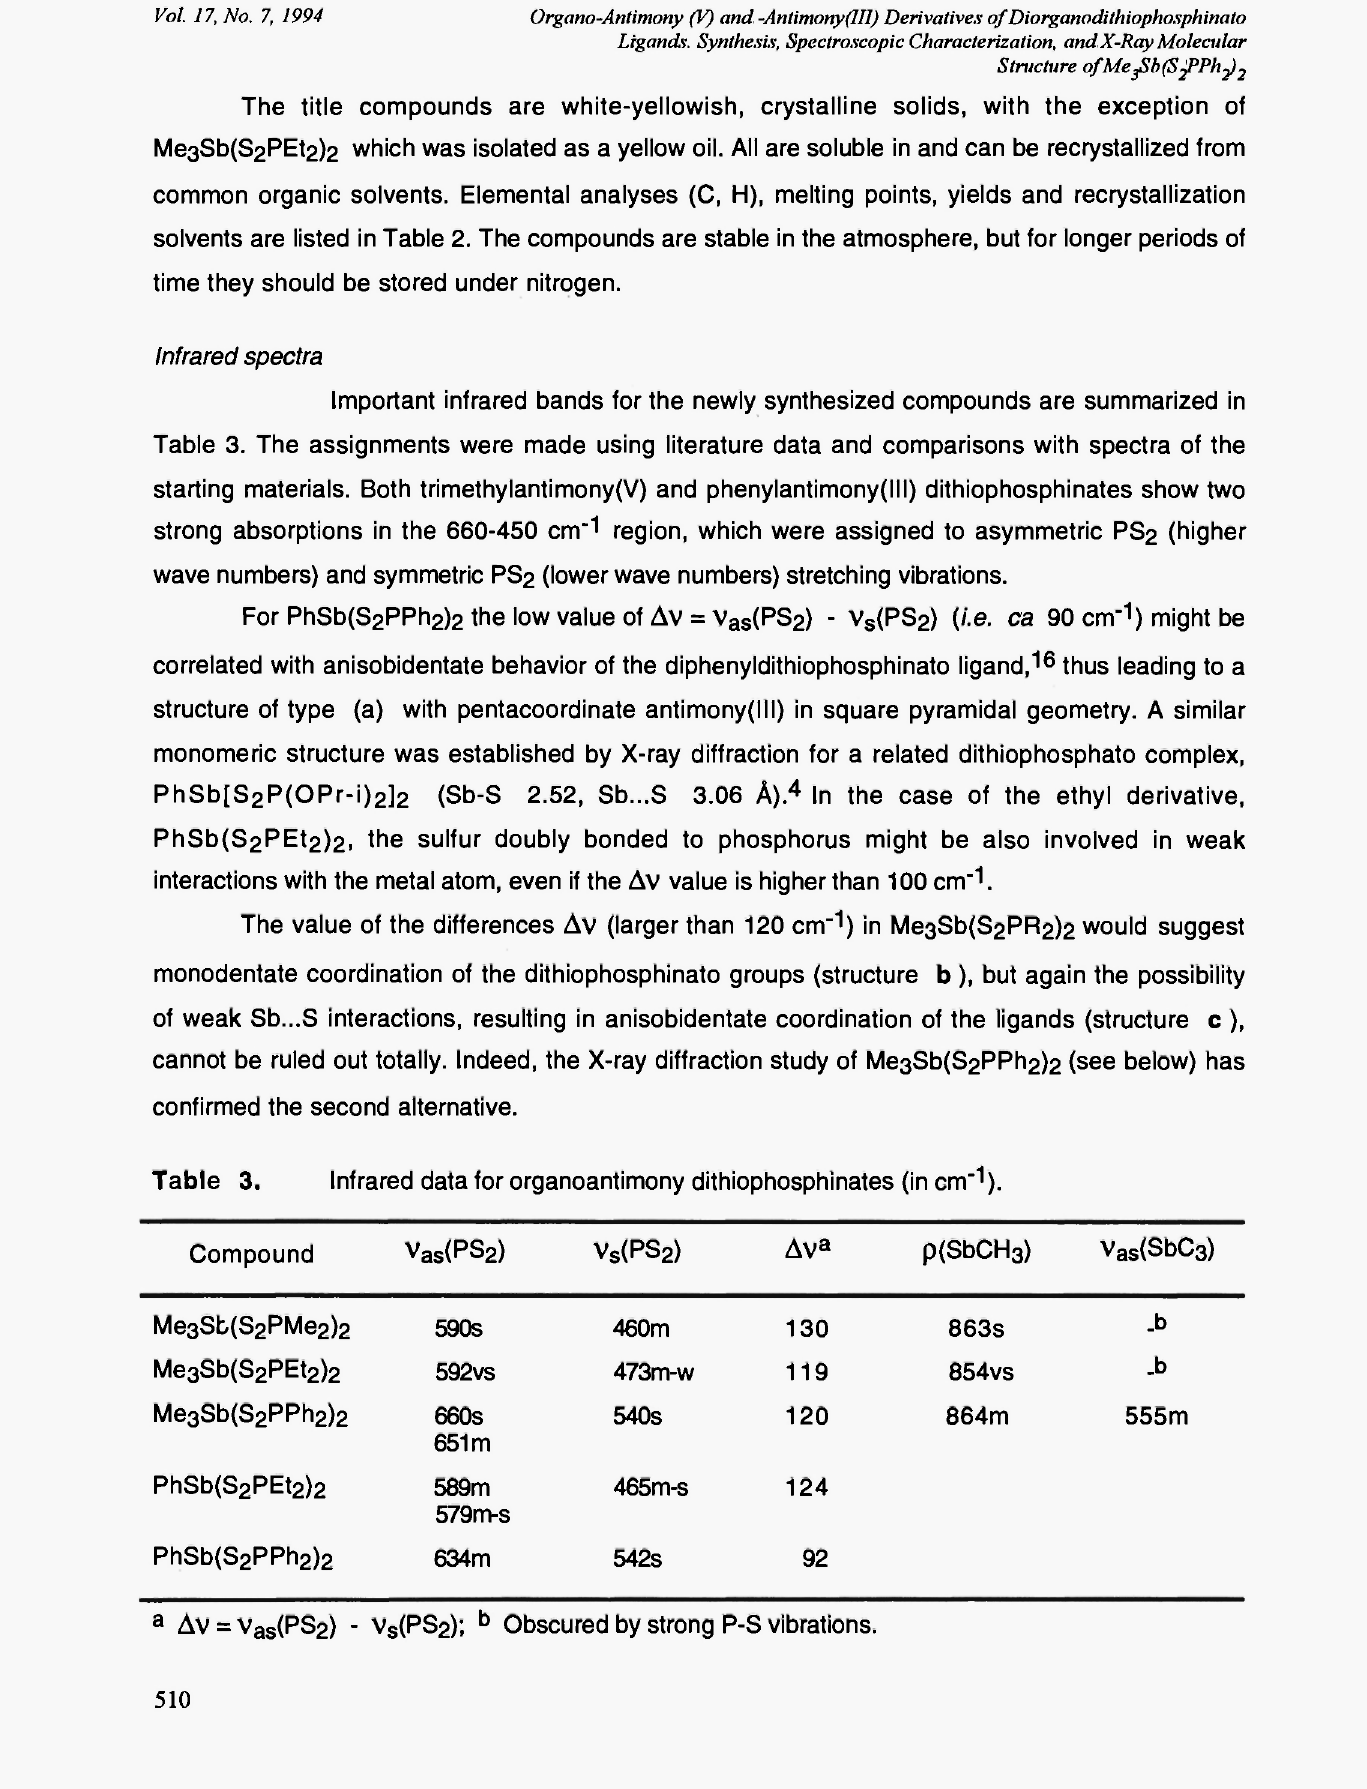
Table 3. Infrared data for organoantimony dithiophosphinates (in cm" 1